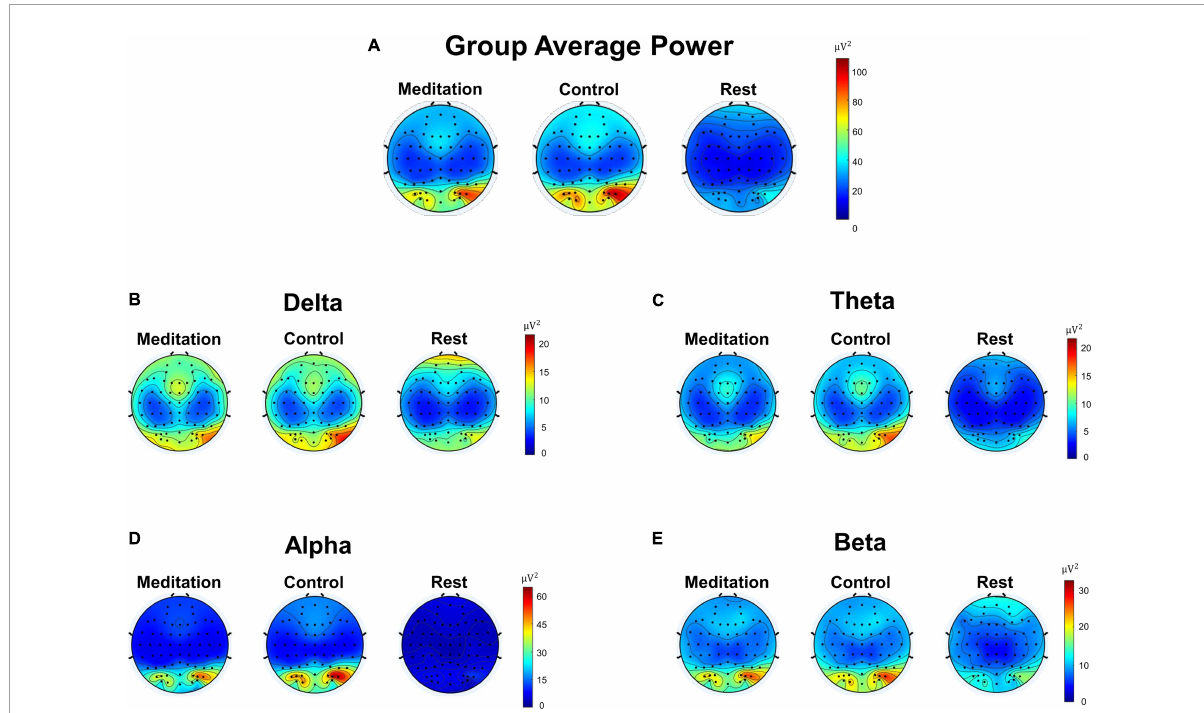
FIGURE2 Scalp topographic maps of group ( n = 21) average Electroencephalography (EEG) power of different frequency bands during meditation and control interventions. (A) Pre-processed average EEG power not filtered to any specific frequency band (1–100 Hz). (B) Average delta